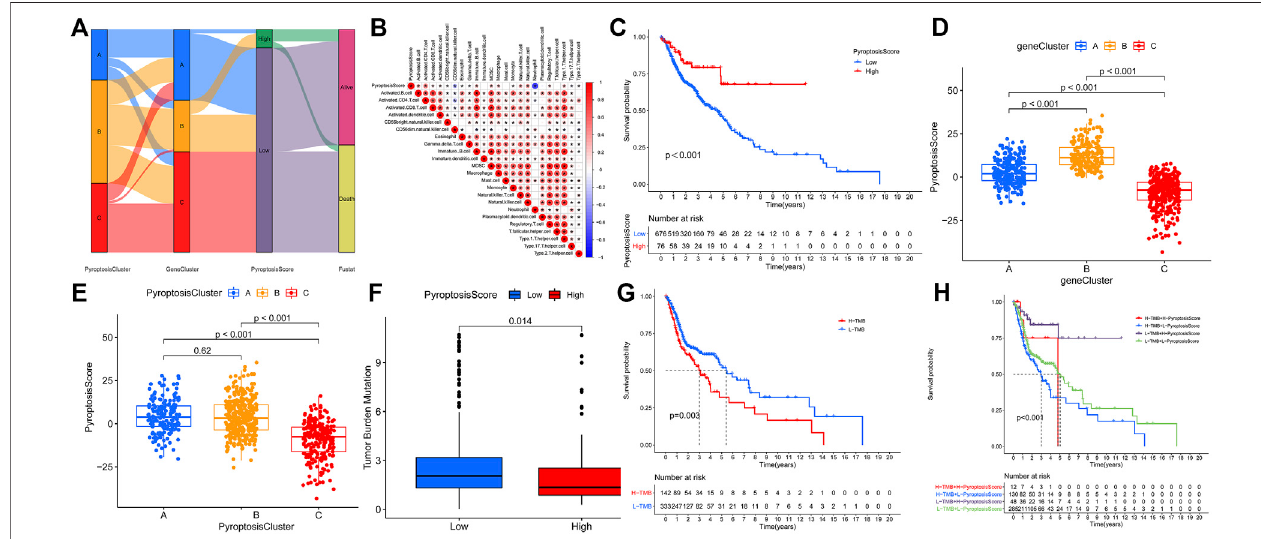
FIGURE 4 | Construction of the pyroptosis gene signatures. (A) . ggalluvial diagram was used to visualize the relationship between PyroptosisScore, PyroptosisCluster, andGeneCluster. (B) .Correlationbetweenthein fi ltratingcelltypesandthePyroptosisScore. (C) .ValueofthePyroptosisScoreinpredictingpatients ’ prognosis. (D) . Connection between the PyroptosisScore and pyroptosis GeneClusters. (E) . Connection between the PyroptosisScore and PyroptosisCluster. (F) . Connection between the high/low score group and TMB. (G) . High TMB group suggested a poorer prognosis. (H) . Prognosis results in different TMB when combined with the